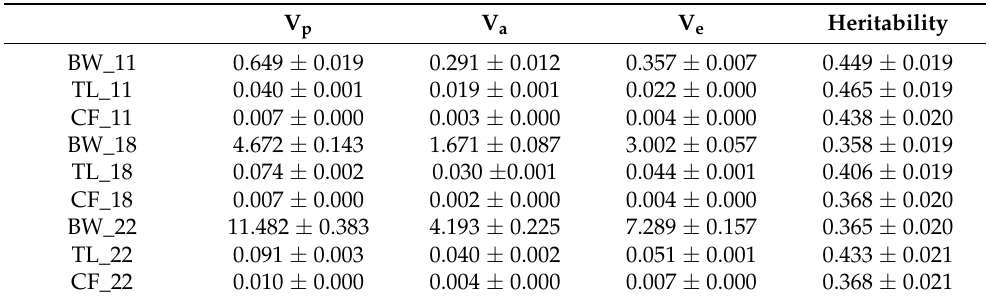
Table 2. Variance component and estimated heritabilities for olive flounder ( Paralichthys olivaceus ): BW, TL, and CF traits in 3 periods of time ( ± SE